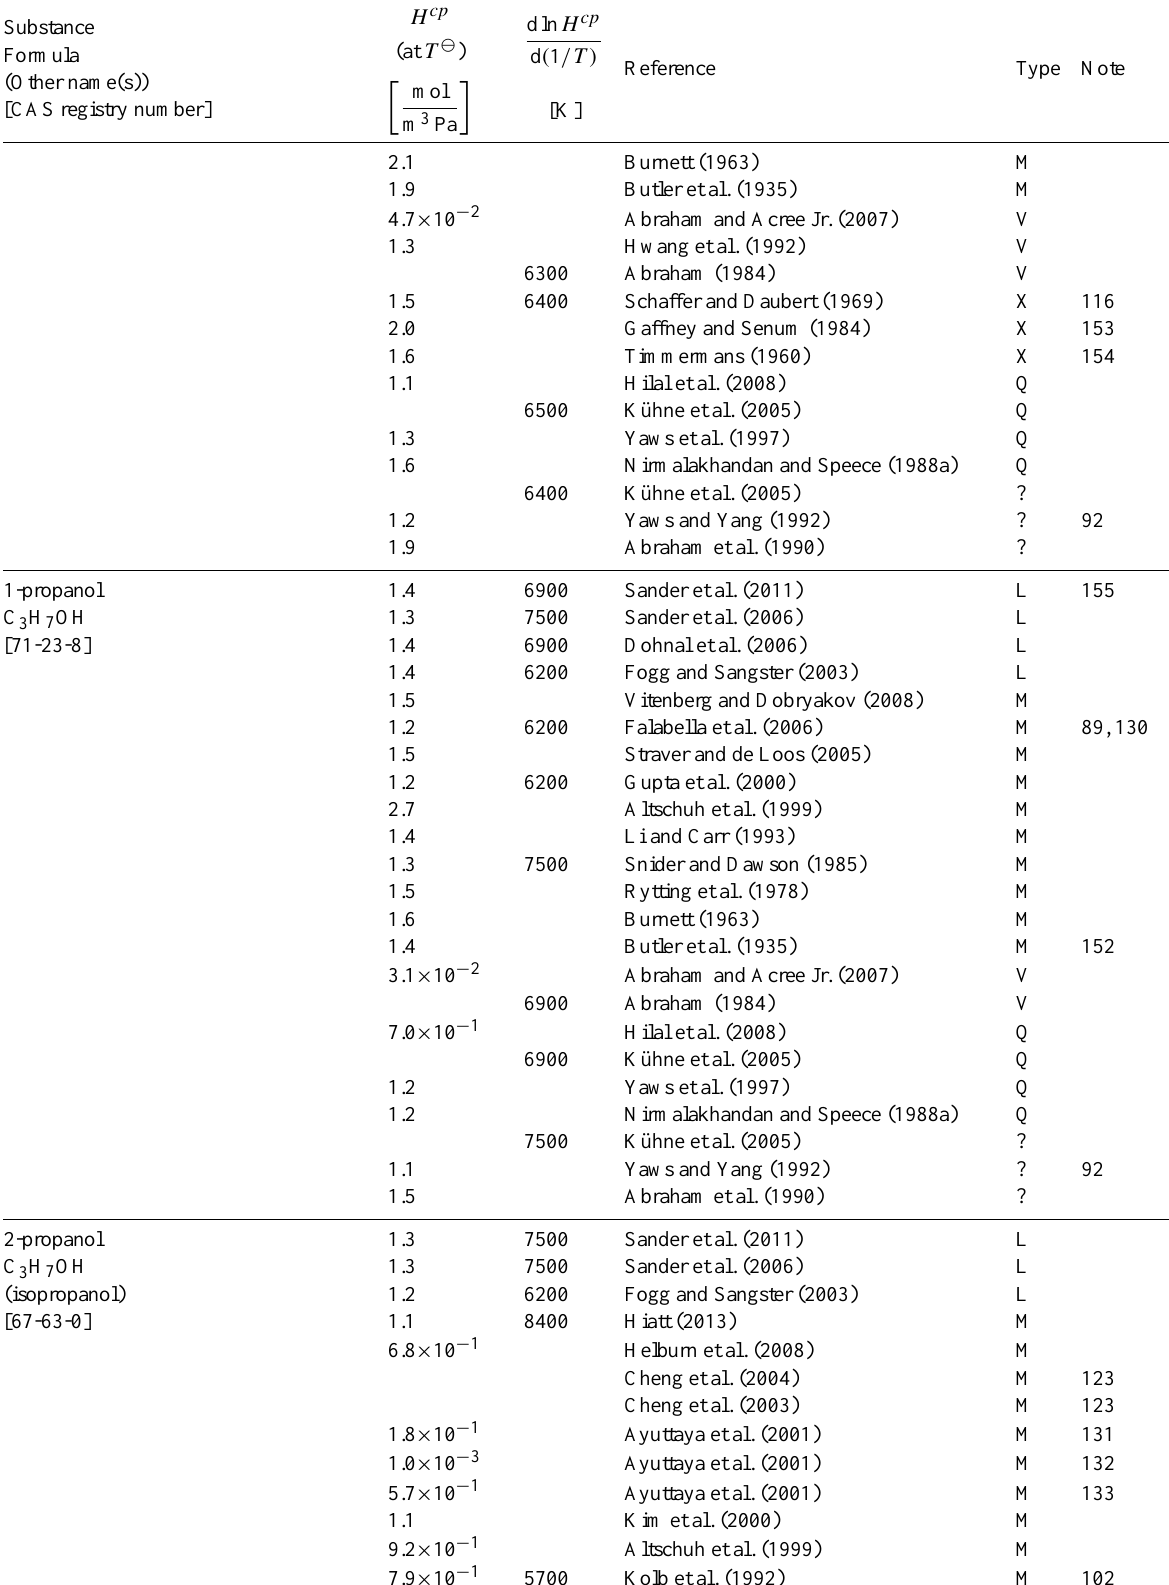
Table 6: Henry’s law constants for water as solvent